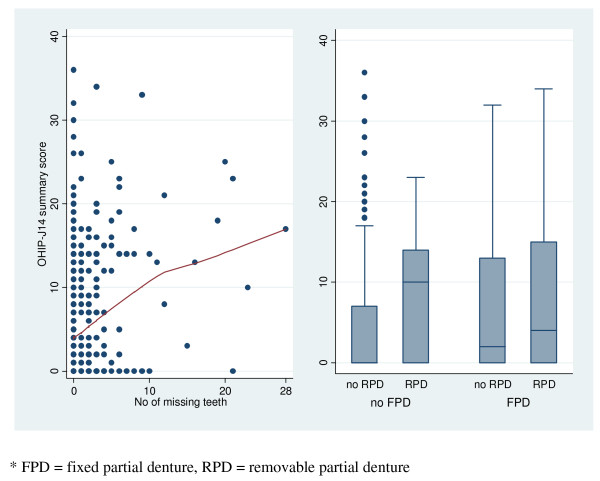
Scatter plot of OHIP-J14 scores in subjects with different number of missing teeth (including locally weighted scatter plot smoothing, lowess, that fits a flexible curve to the data) and a boxplot of OHIP-J14 scores in subjects with different denture status